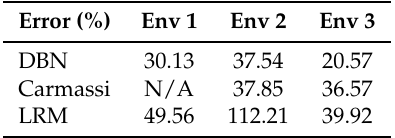
Table 4. Estimation error of ET vs. GDT for the micro-tomatoes in three different environments: Env 1 (warm and bright), Env 2 (shaded and emergency heating), and Env 3 (indoor and artificial